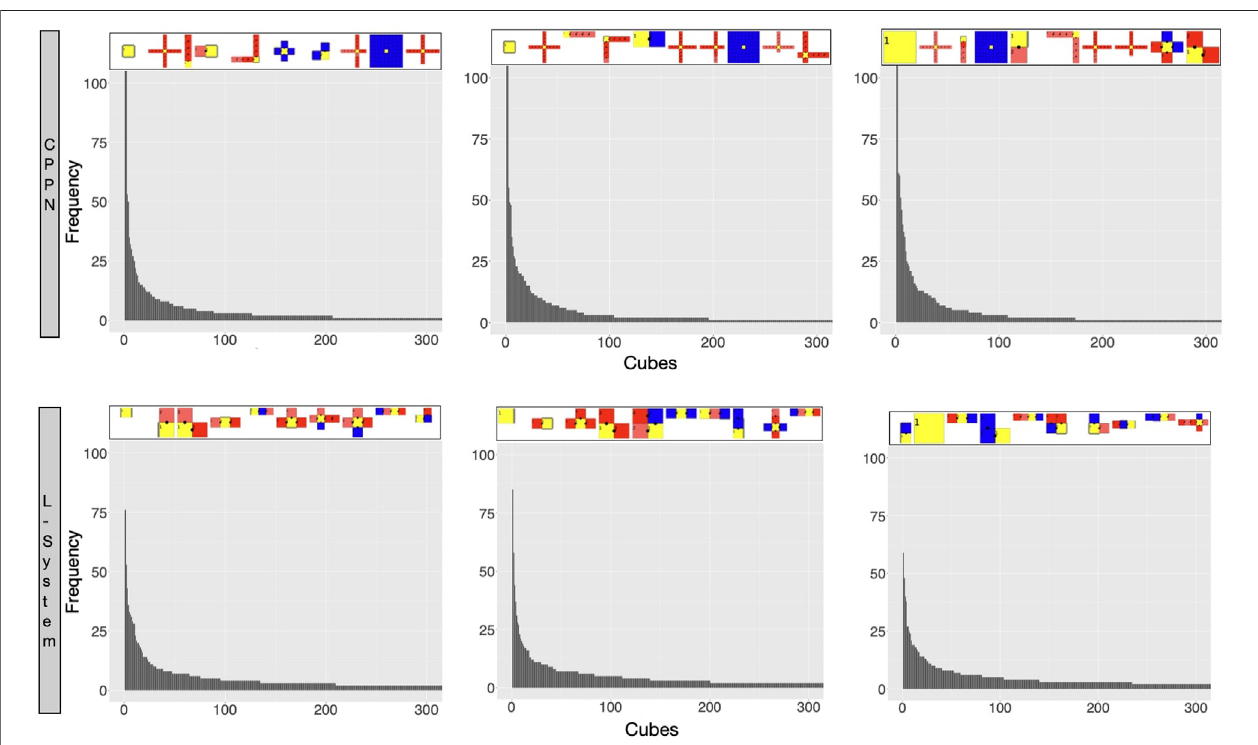
FIGURE 10 | Robots most frequently sampled by the reproduction operators during the secondary initialization. Each bar in the histogram represents how many timesrobots that fi t into that cube were ever sampled (born). Each cube ispart of a large multidimensional cube where each dimension isone of the morphological traits divided into 100 bins. The robots on the top of the plot are the representative of the cubes with the highest frequency (ordered from higher to lower). Each histogram concerns one random run. Plots were scaled in x and y to 300 and 100 respectively.